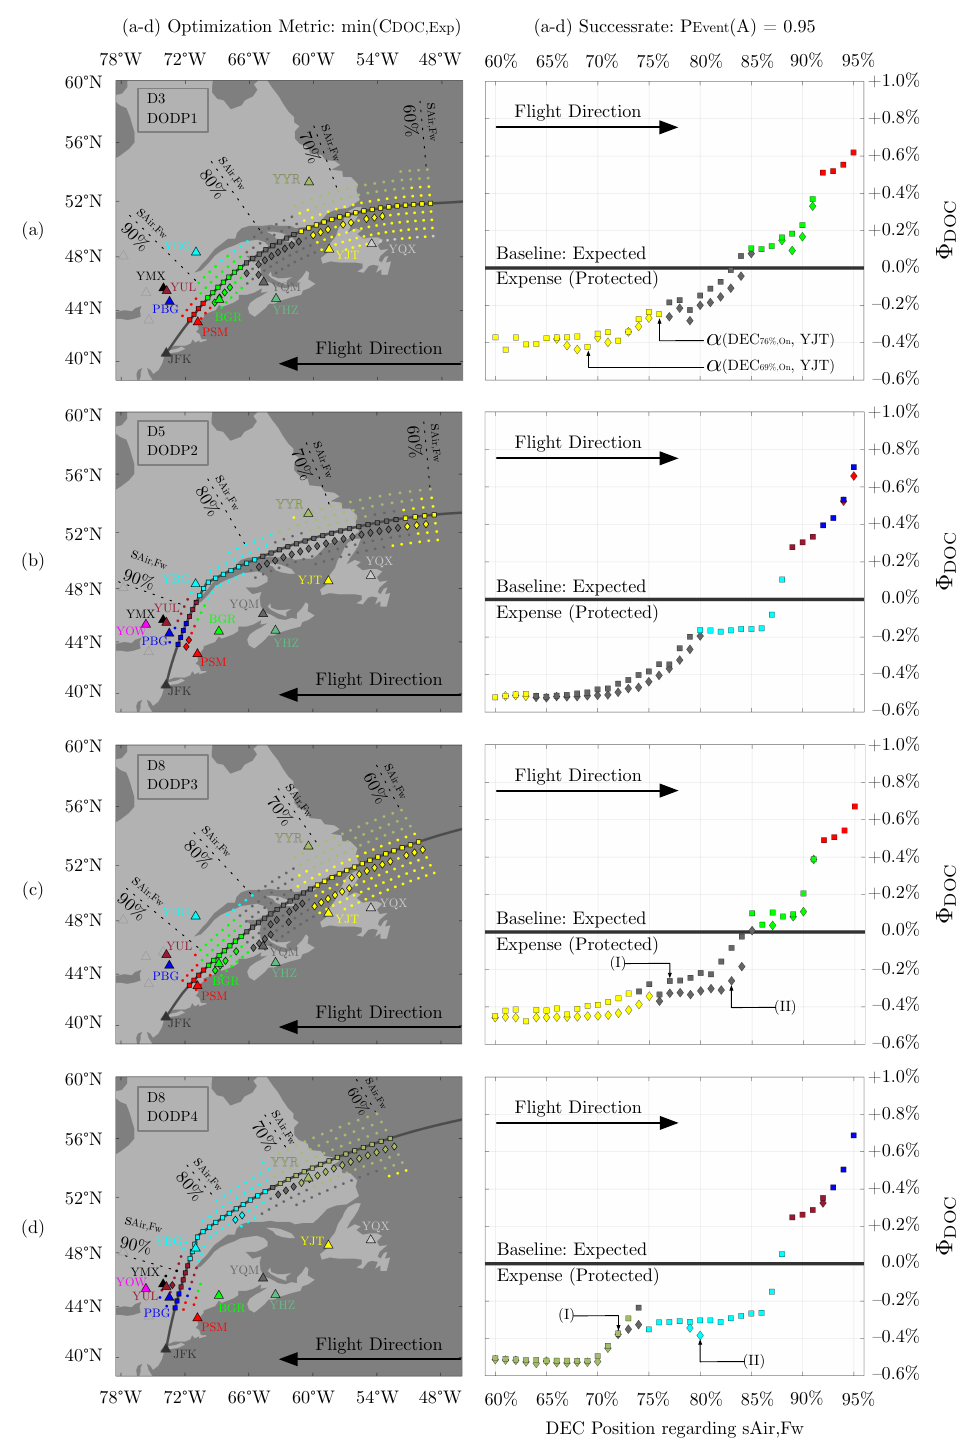
Figure 5. Optimization potential regarding expected expense, resulting from unprotected actions compared to protected actions. The depicted cases ( a – d ) show exemplarily four combinations of DODP and meteorological day for an assumed value of formation success probability P Event ( A ) =